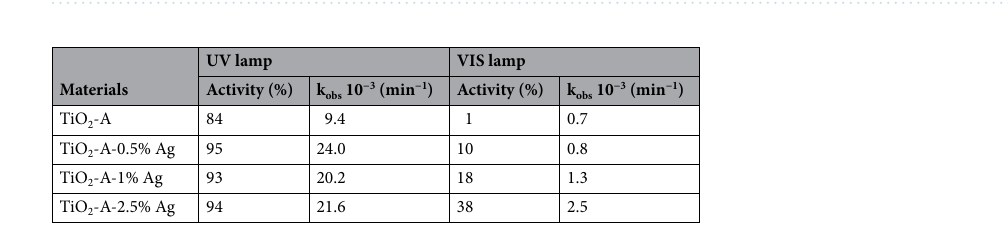
Figure 14. Photocatalytic degradation processes of AO7 for TiO 2 -A-n% Ag ( A , C ) and MM-g-CN-n% Ag ( B , D ) samples. ( A , B )—UV lamp irradiation; ( C , D )—VIS lamp irradiation. Concentration of AO7: 7.14 × 10 –4 mol/L; mass of the catalyst: 50 mg.